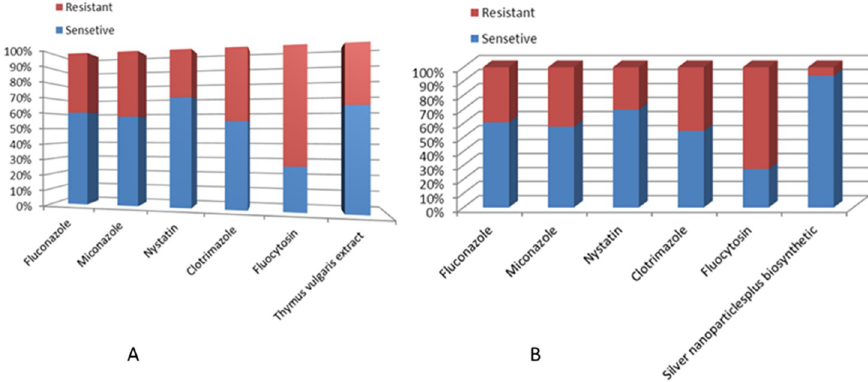
Fig 12. (A) The percentage of resistant isolates to chemical antifungal agents and T/AgNPs. (B) Anti-fungal sensitivity testing of commercial antifungal versus biogenic silver nitrate.